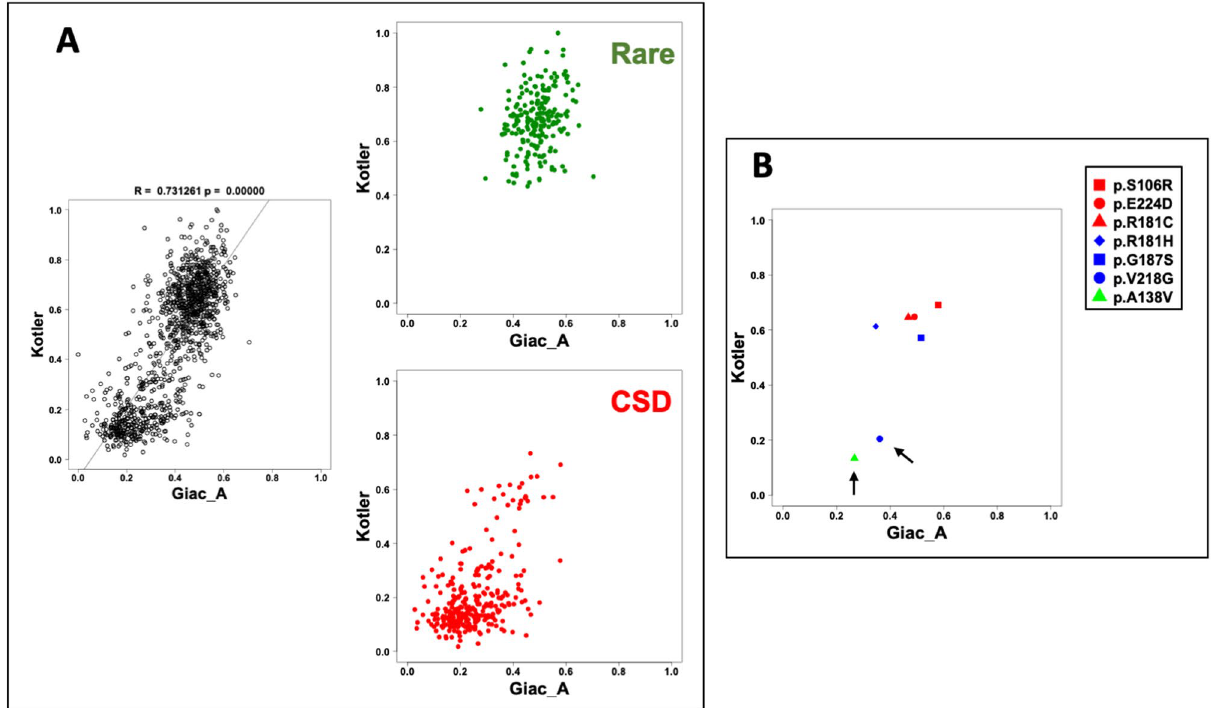
Figure 4. ( A ) TP53 variants can be divided into two classes according to their loss of activity. The binary comparison between two studies (Kotler and Giac_A) has been split into two panels, with variants found in the CSD in the lower right panel (red) and rare TP53 variants (variants found once in or absent from the database) in the upper right panel (green). Data for other read-outs are shown in Supplementary Fig. 3. ( B ) Position of the 7 CSD outlier variants in different binary comparison. Two variants, p.A138V and p.V218G (shown by black arrows), display no loss of activity in the yeast assay (top figures) but are inactive using the various mammalian readouts (bottom figures). Other variants associated with splice defects are also displayed in the figure. Data for other read-outs are shown in Supplementary Fig. 5.